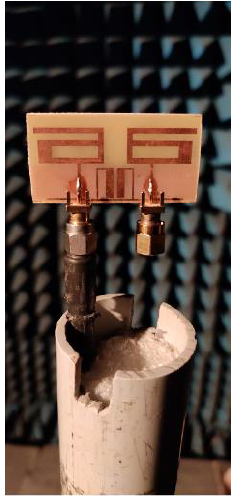
( b ) Figure 15. ( a ) Measurement setup of vector network analyzer (VNA); ( b ) simulated and measured results of resonance and isolation.